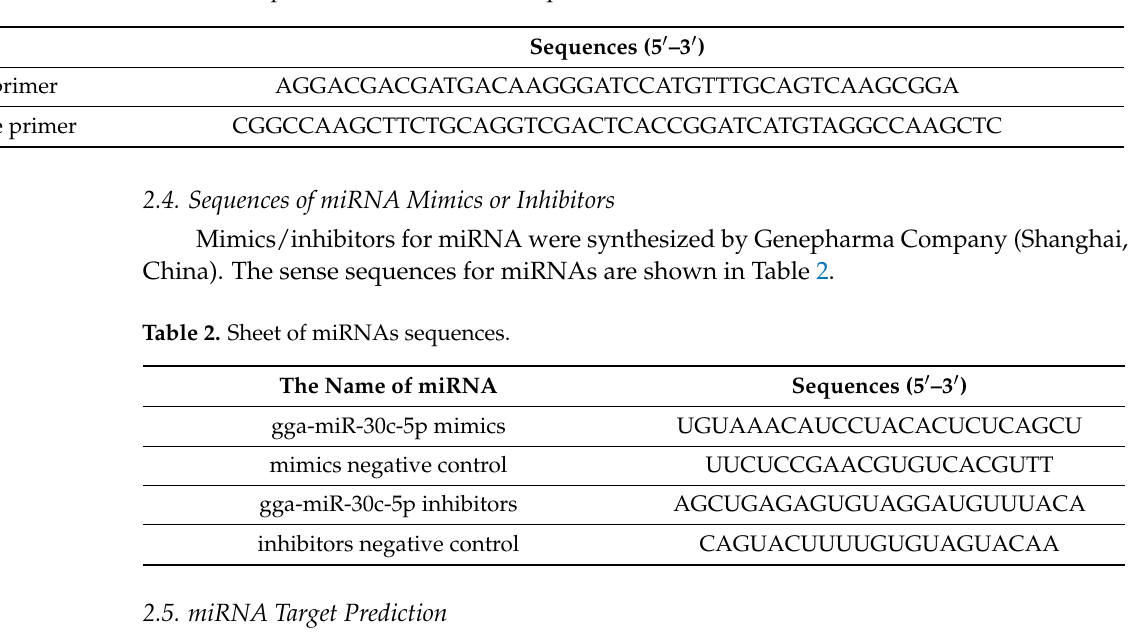
Table 1. The primers of PCR for Mcl-1sequences.